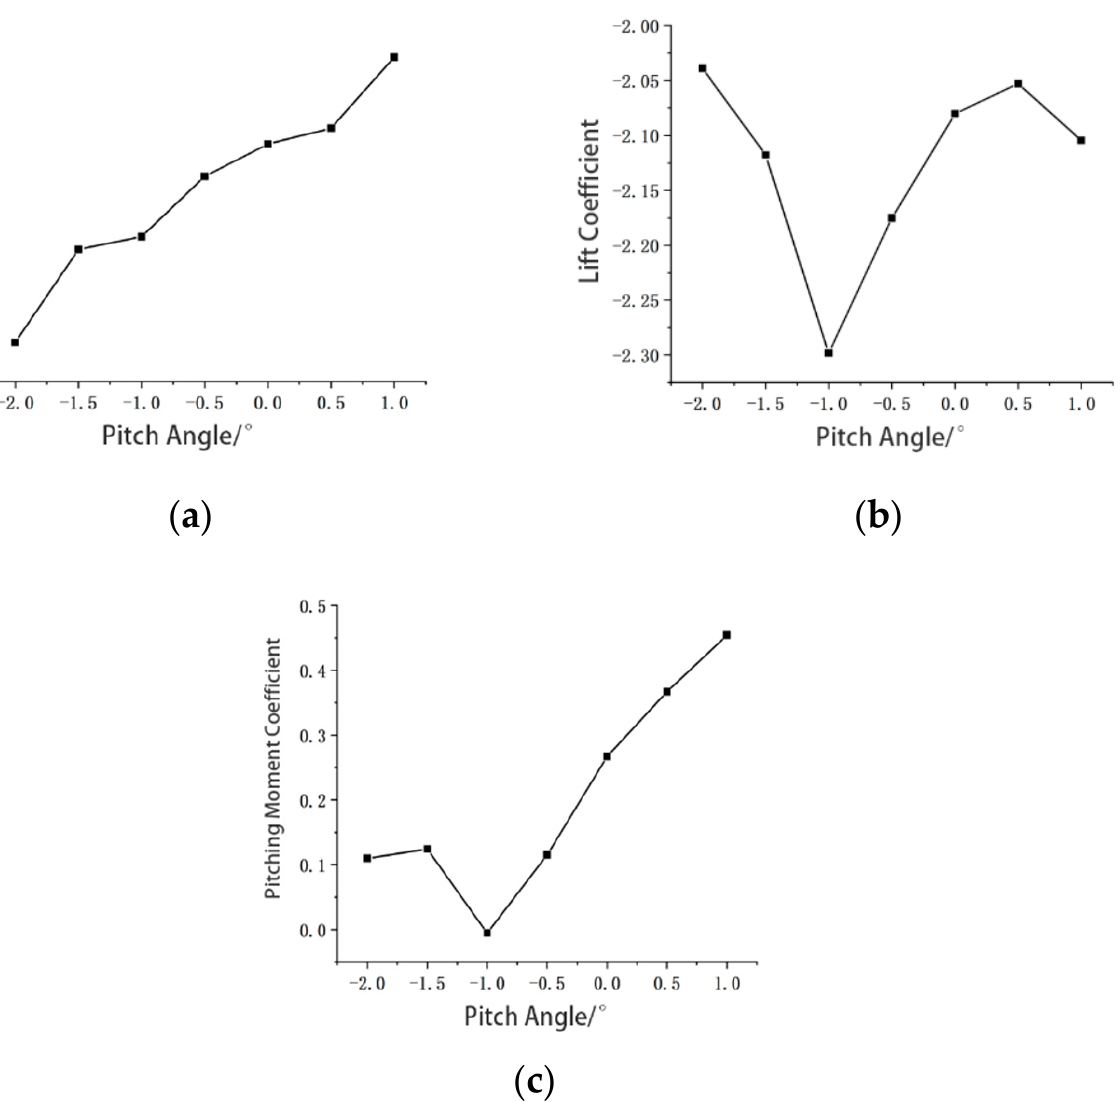
Figure 8. Pitch working condition of the car drag coefficient, lift coefficient and pitching moment curve: ( a ) drag coefficient, ( b ) lift coefficient and ( c ) pitching moment.